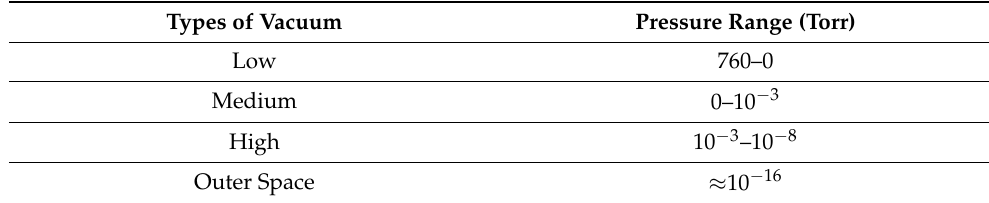
Table 4. VACUUM quality with respect to pressure